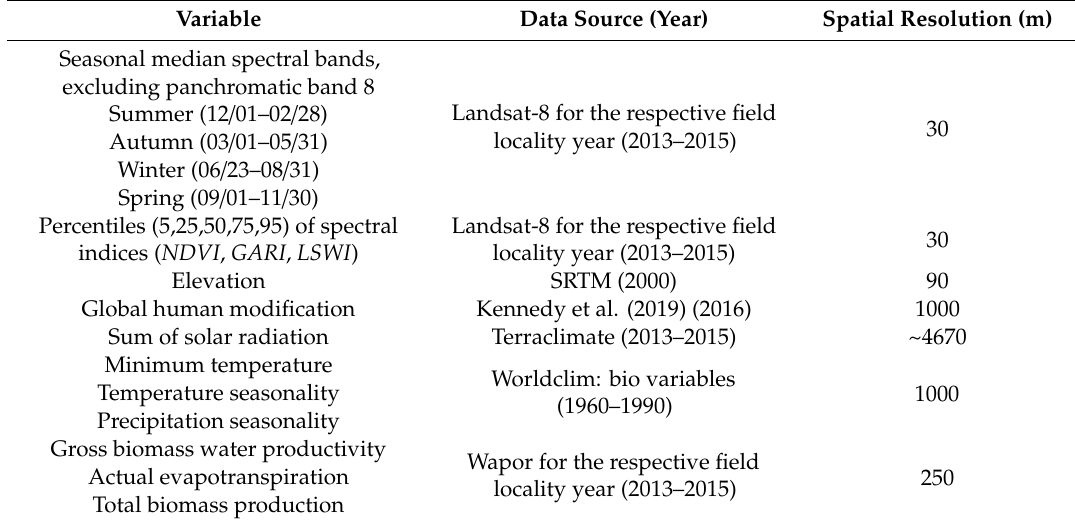
Table 1. The initial 64 explanatory variables used to fit a random forest model that discriminated between water hyacinth and other aquatic vegetation